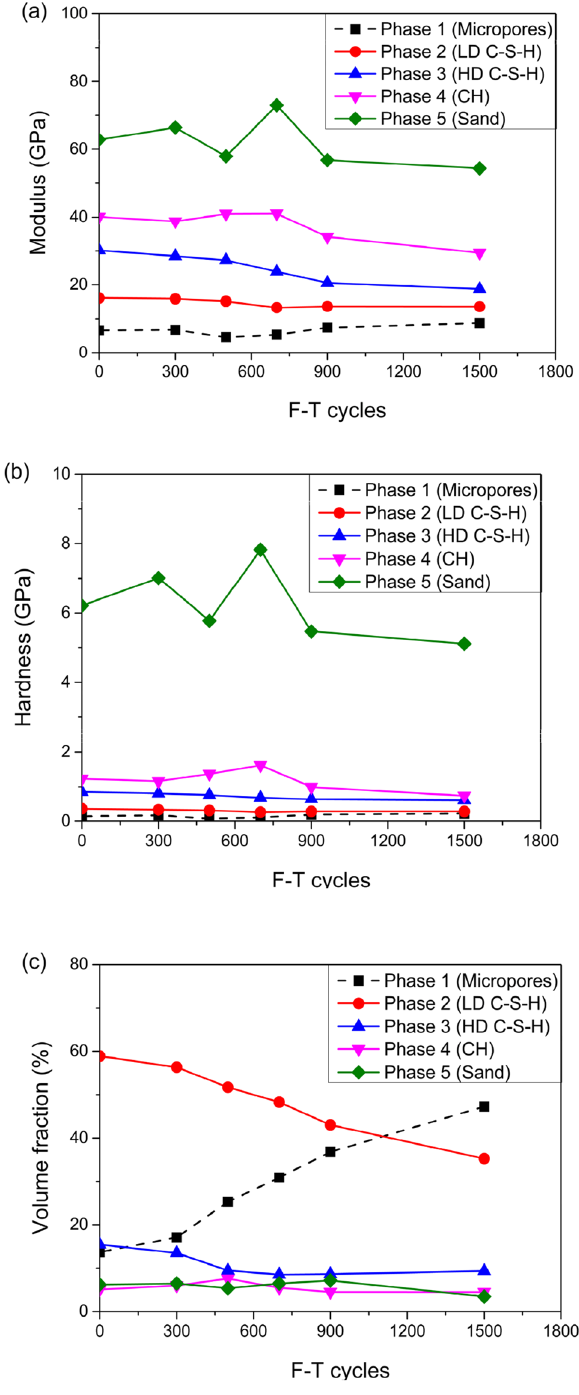
Figure 6. The deconvolution results of